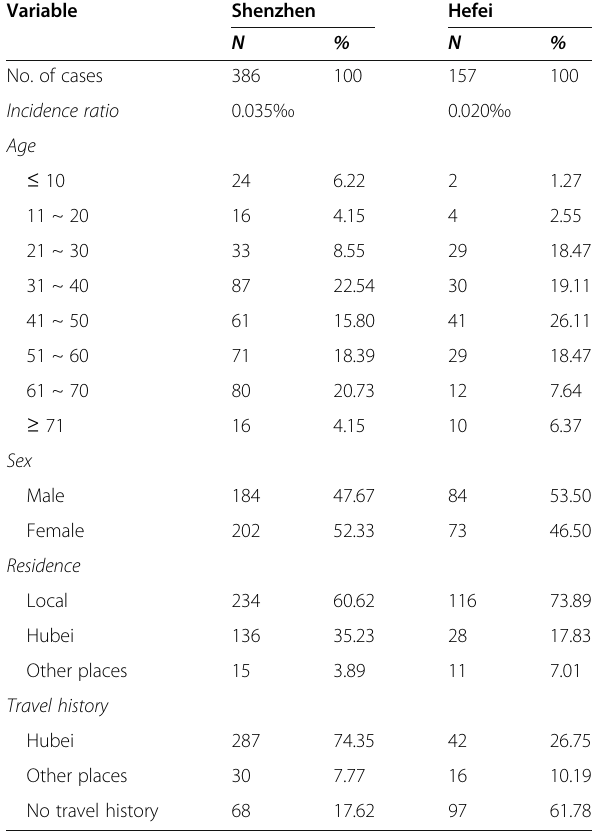
Table 2 Demographic information on infected cases by